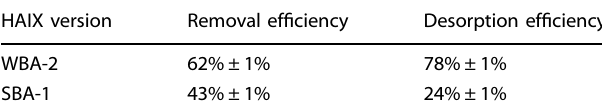
Table 3. Removal and desorption ef fi ciency for SBA-1 and